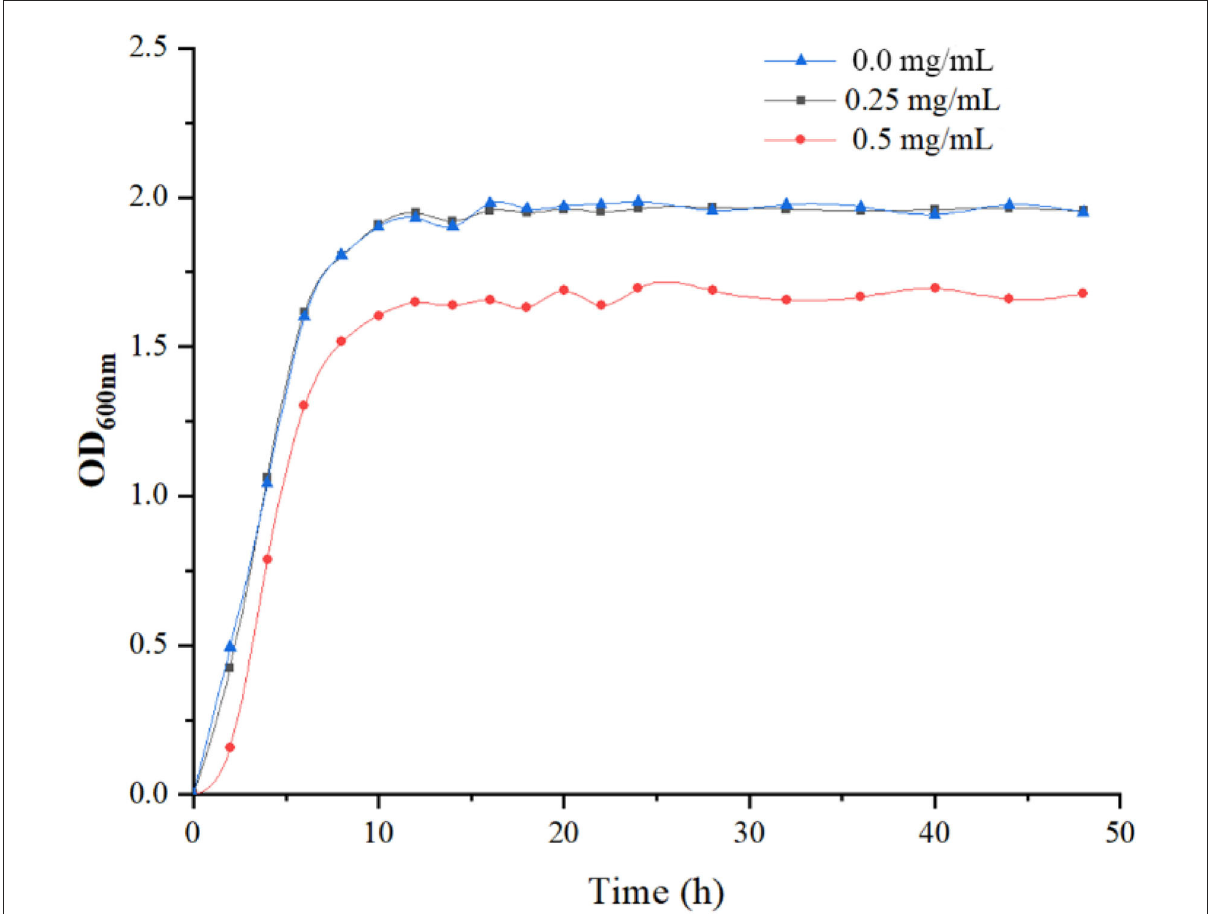
FIGURE1 Growth curve of L. plantarum in de Man, Rogosa and Sharpe (MRS) medium at 37 ◦ C.